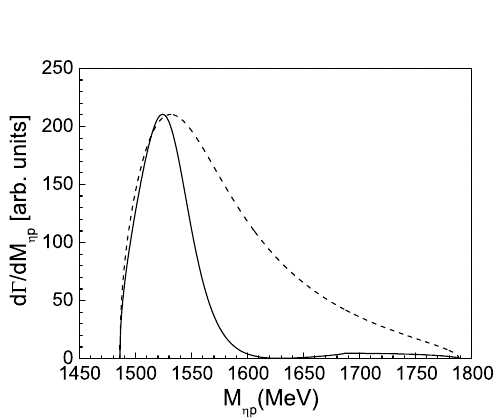
→ ¯ K 0 η p decay. in the Λ + K 0 p c